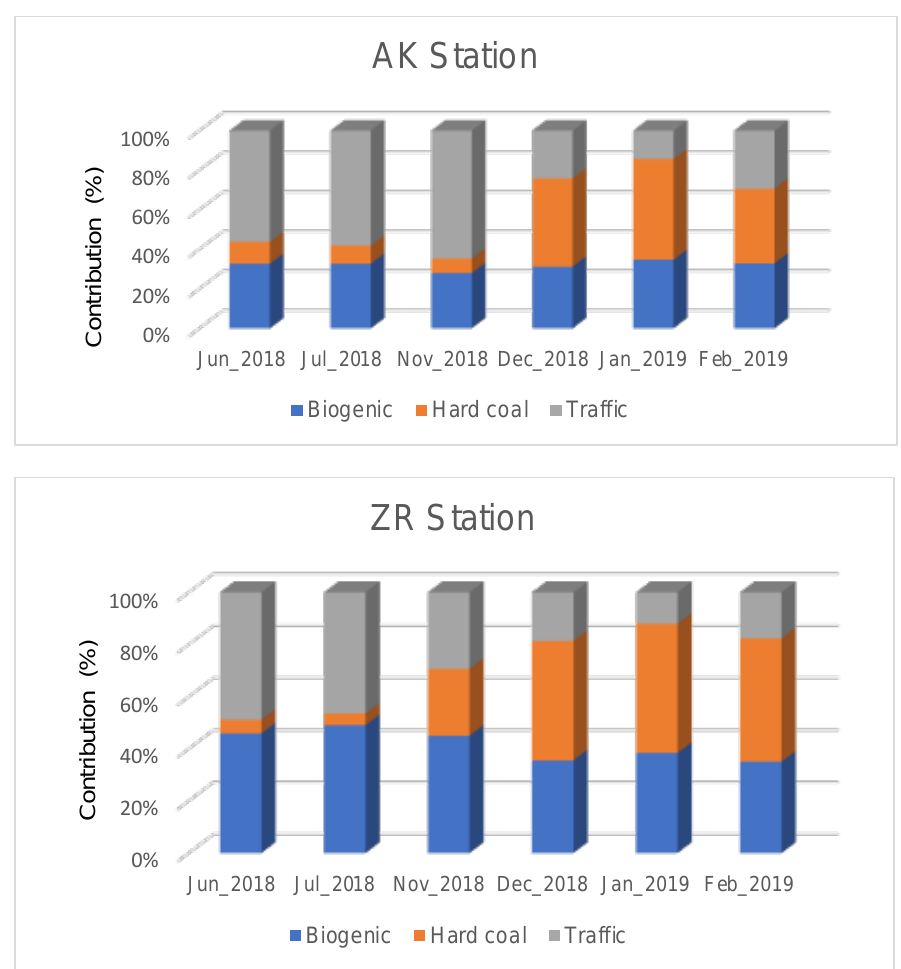
Figure 4. Monthly contributions of carbon sources in PM10 at both stations (traffic-dominated and urban-background) (in%) calculated using isotope mass balance equations.